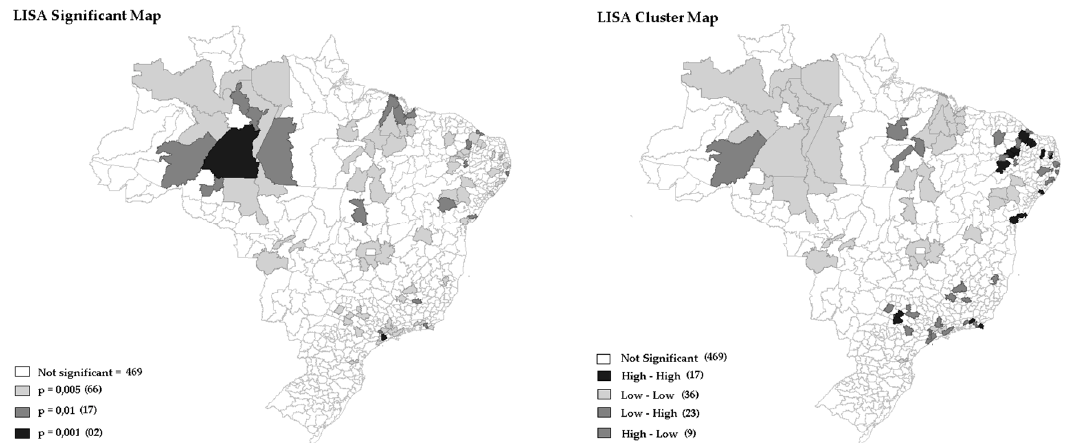
Figure 2. Univariate Local Moran’s by LISA of oral and oropharynx cancer weighted by female, Brazil, 2016.